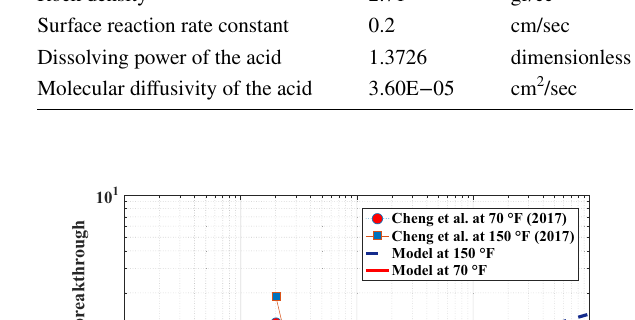
Fig. 4 Comparison of dissolution regimes observed by Golfier et al. (2002) and by this study: a face dissolution, b conical wormhole, c dominant wormhole, and d ramified wormhole